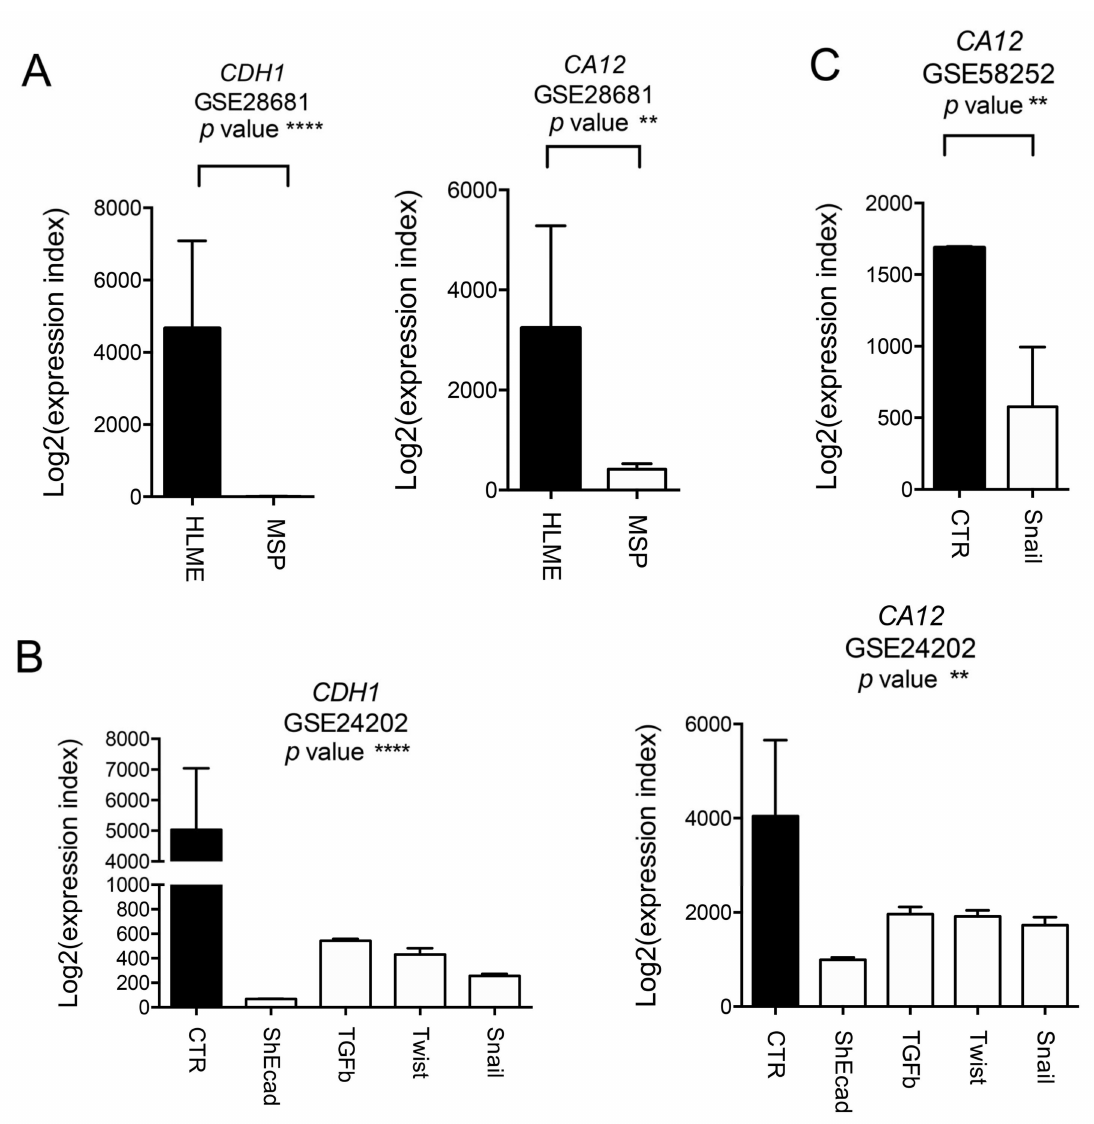
Figure 4. CA12 regulation during epithelial mesenchymal transition (EMT). ( A ) Analysis of mRNA expression in breast cancer cell lines was performed using GEO dataset. Box plots show CDH1 and CA12 expression levels in the mesenchymal subpopulation (MSP) of cells isolated from immortalized human mammary (HMLE) cells. Data were obtained from the GEO dataset GSE28681. The p -value for the comparison between the two groups was determined using the Student’s t -test. p -value ** < 0.01, p -value **** < 0.0001. ( B ) Analysis of mRNA expression in breast cancer cell lines was performed using GEO dataset. Box plots show CDH1 and CA12 expression levels in immortalized HMLE breast epithelial cells retrovirally transduced in culture with vectors encoding EMT-inducing genes. Data were obtained from the GEO dataset GSE24202. The p -value for the comparison between di ff erent groups was determined using the ANOVA test. p -value ** < 0.01, **** < 0.0001. ( C ) Analysis of mRNA expression in breast cancer cell lines was performed using GEO dataset. Box plots show CA12 expression levels in MCF-7 control (CTR) cells and MCF-7 cells over-expressing Slug. Data were obtained from the GEO dataset GSE58252. The p -value for the comparison between the two groups was determined using the Student’s t-test. p -value ** <